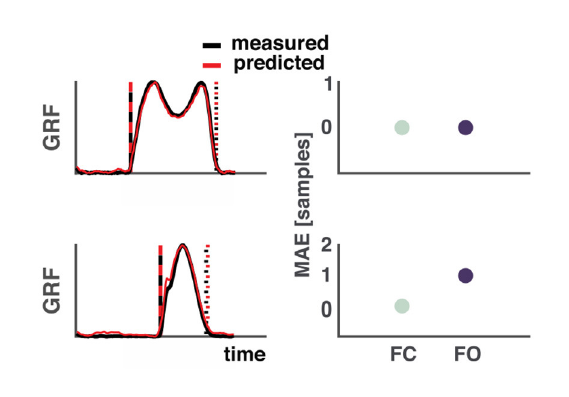
FIGURE2 Example of the estimation of foot contact and foot off events from measured and predicted ground reaction forces. Top : Walking, bottom : Running. Left side : Measured vertical GRF waveforms are depicted in black and the predicted ones in red. The vertical dashed lines represent foot contact (black: measured, red: predicted) and the dotted lines represent foot off (black: measured, red: predicted). Right side : Differences in samples between events based measured and predicted vertical GRF. One sample equal ∼ 7ms. MAE, mean absolute error; FC, Foot contact; FO, Foot off.